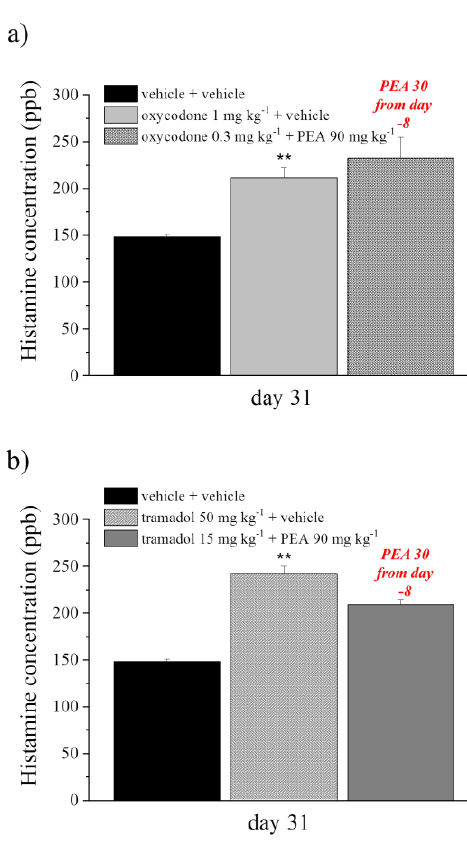
Figure 10. Effect of different combination of opioids and PEA on histamine plasma levels. Animals were orally treated with the vehicle or pre-emptive PEA (30 mg kg − 1 daily in the evening) for the duration of the experiment, starting on Day − 8. To maintain a significant increase in the pain threshold (90 ± 10 g) vs. the baseline, beginning on Day 1, increasing daily doses of ( a ) oxycodone (0.3 – 1 mg kg −1 ), or oxycodone (0.3 mg kg −1 ) and PEA (30 – 90 mg kg −1 , p.o.) or ( b ) tramadol (15 – 50 mg kg −1 ), or tramadol (15 mg kg −1 ) and PEA (30 – 90 mg kg −1 , p.o.) were injected s.c. On Day 31, the histamine concentration was measured in the plasma by HPLC analysis. Data represent the mean ± S.E.M. of 12 rats. Statistical analysis was one- way ANOVA followed by Bonferroni’s post hoc comparison. * * p < 0.01 vs. vehicle + vehicle group.